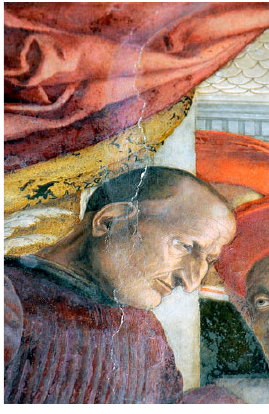
Figure 3. Detail of the crack